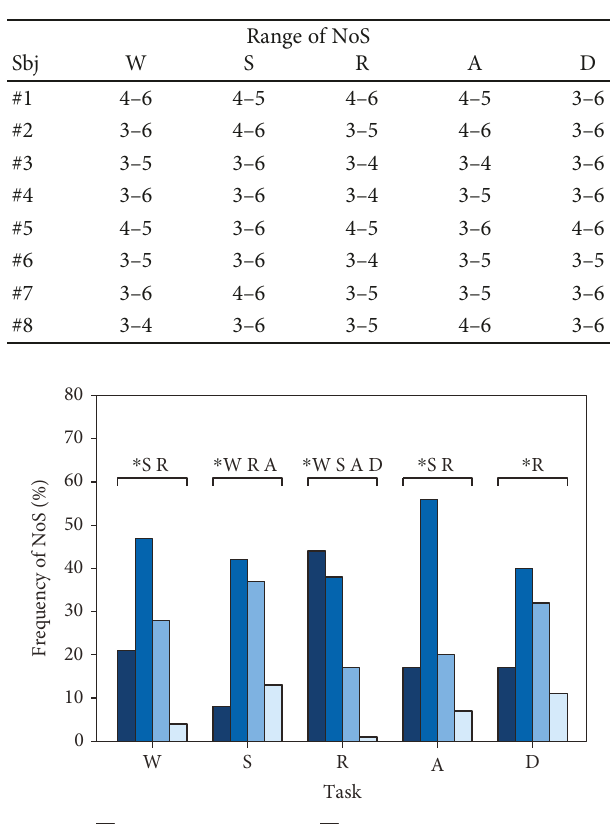
Table 1: Range of number of synergies for each subject across the sessions related to each task.